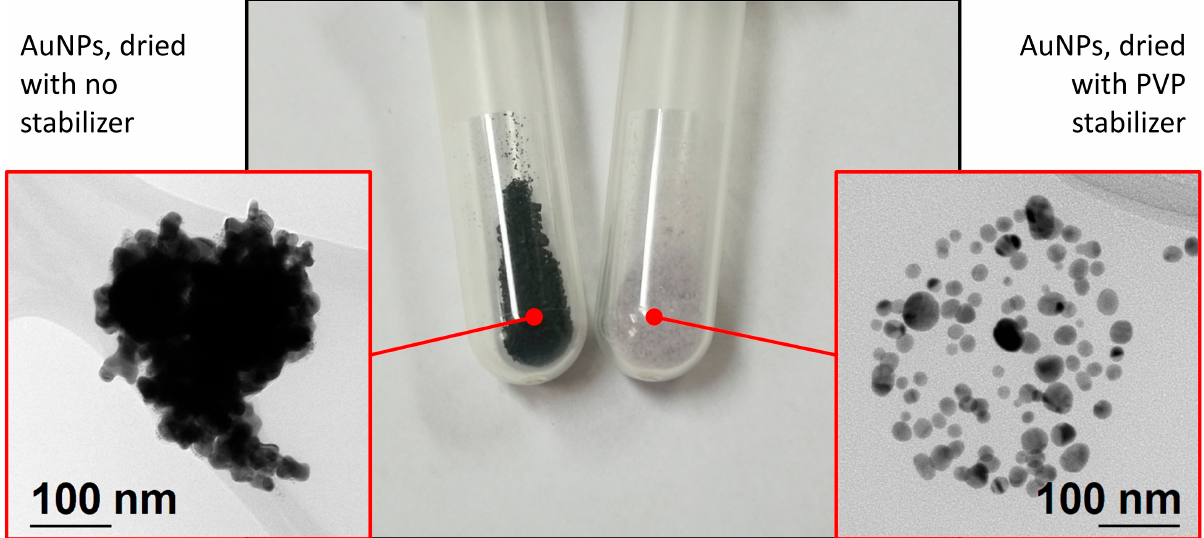
Figure 5. Comparison of the dried AuNPs’ dispersion and agglomeration from TEM images, with and without a stabilizer.